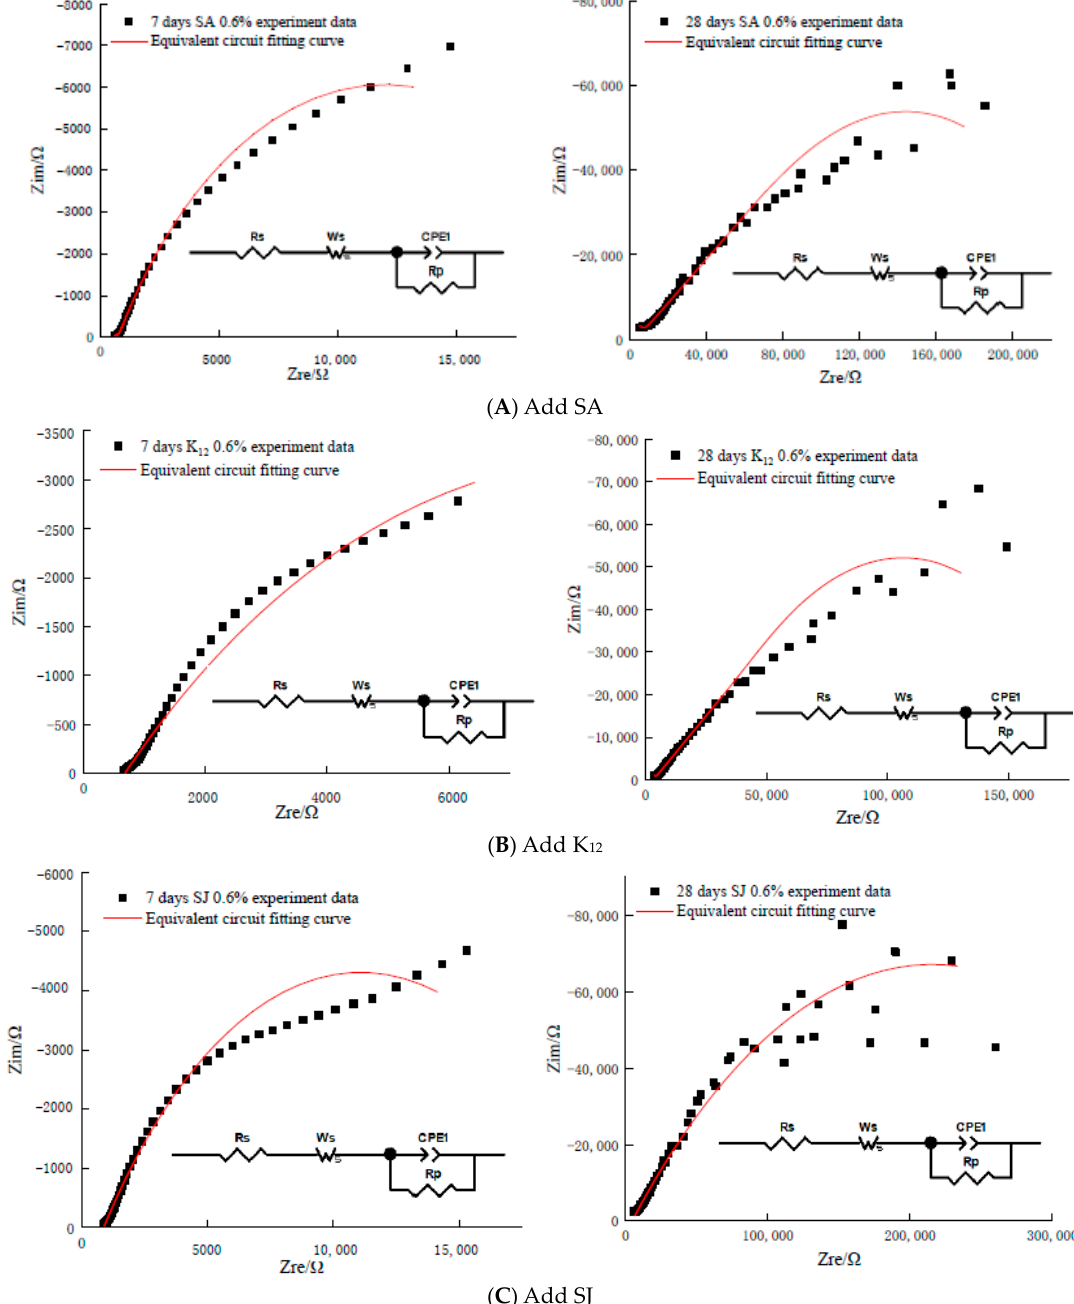
Figure 9. Equivalent circuit diagram of air entraining agent added to the filling body of different curing ages. ( A ) Add SA; ( B ) Add K 12 ; ( C ) Add SJ. Table 5. Equivalent circuit model parameters.